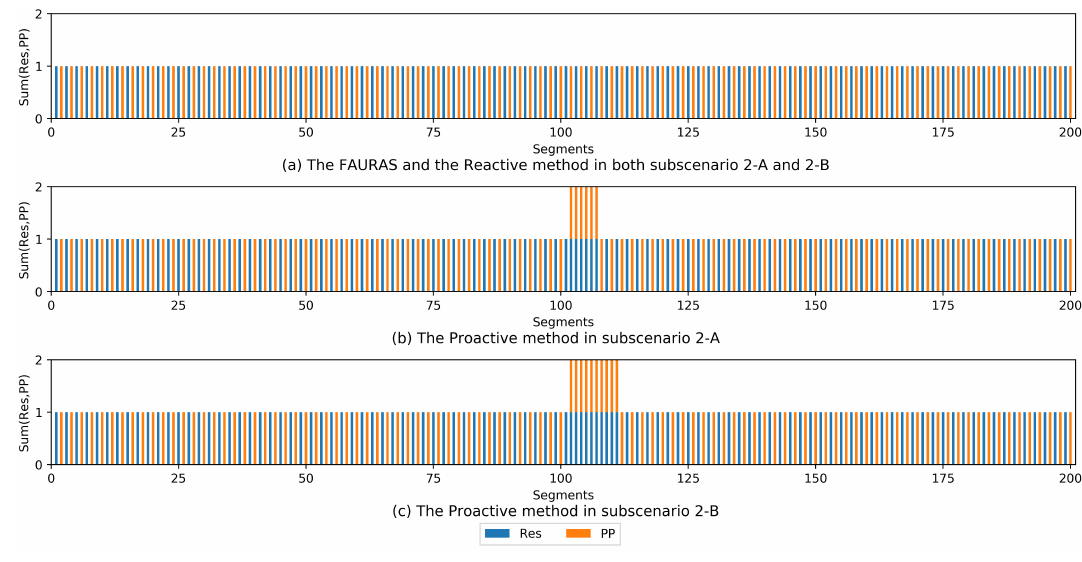
Figure 8. The sum of HTTP Responses and PUSH_PROMISE frames the client a 1 received per